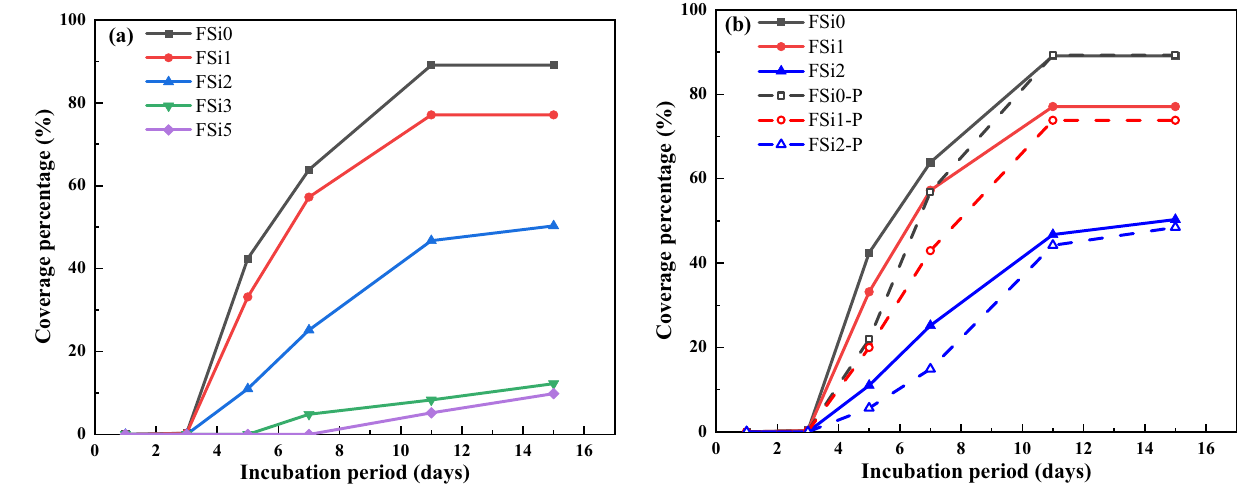
Figure 3. ( a ) Mycelium growth of F. oxysporum grown with different concentrations of Si source; ( b ) Comparison of mycelium growth between F. oxysporum grown with PP fabrics and without PP fabrics feeding on the same